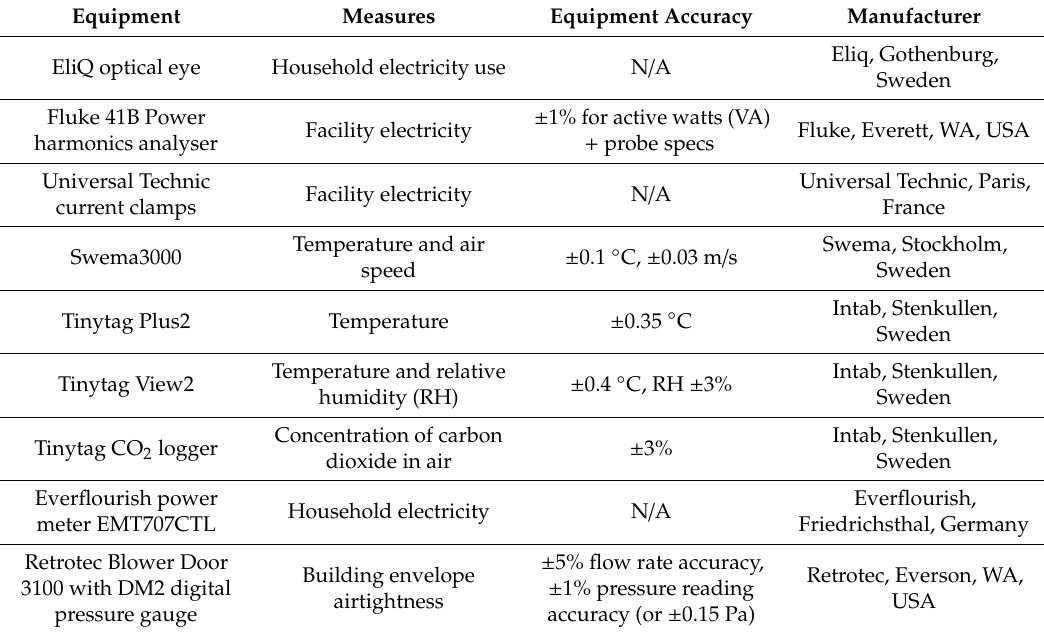
Table 5. Accuracy and area of use for measuring equipment used in the study. N / A—not applicable.